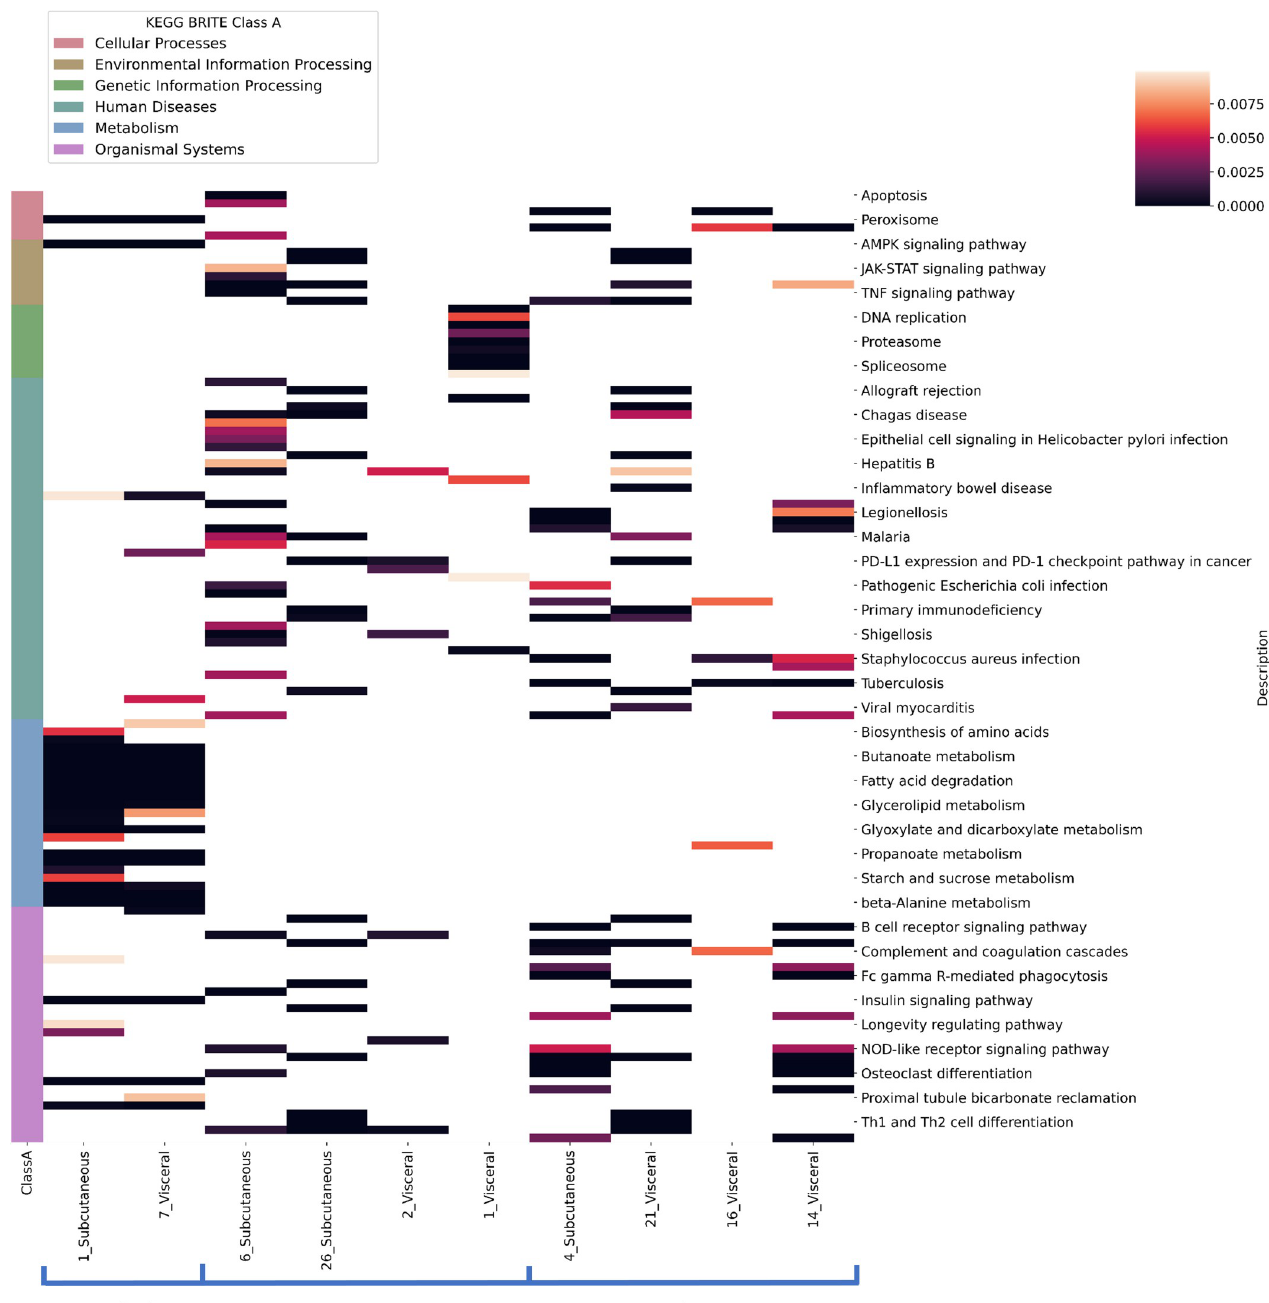
Fig 2. Pathway enrichment analysis of ten representative WGCNA modules. The significantly enriched KEGG pathways (adjusted p-values < = 0.01) and enrichment scores calculated for subcutaneous and visceral adipose are presented. The columns present the modules (that include many labeled receptors) in each tissue and the rows represent the significantly enriched KEGG biological pathways. The matrix cells present the enrichment scores of the pathways for each module. The pathways are classified into six classes according to the BRITE classification and highlighted in the annotation column to the left (see the y- axis). For example, you can see that the modules that include many metabolic receptors (highlighted as “Metabolic” on the x-axis) are highly enriched with the “Metabolism” classification (colored in blue on the y-axis).